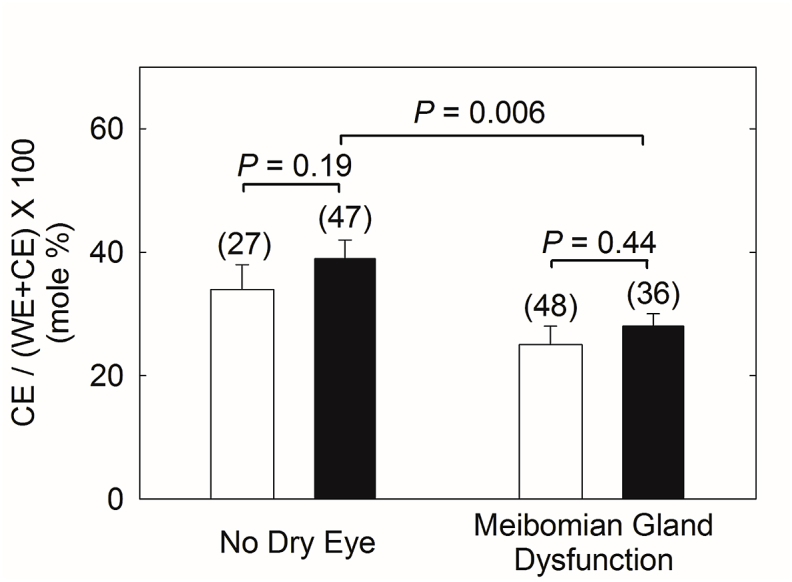
Cholesteryl ester content of human meibum calculated from infrared spectra (see Methods and Results) from the current study (open bars) compared with that calculated using NMR spectroscopy reported previously (filled bars) [4].